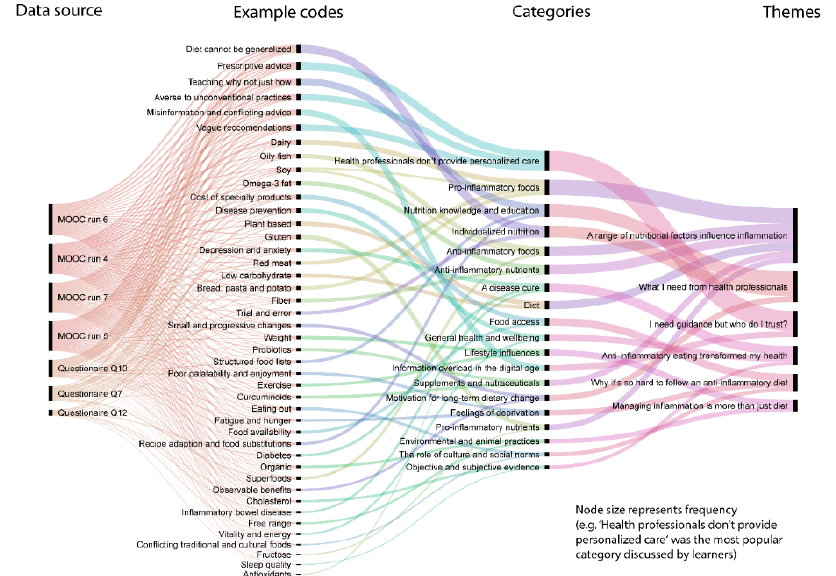
Figure 1. Sankey diagram visualization of the flow of data from coding through to interpretation.